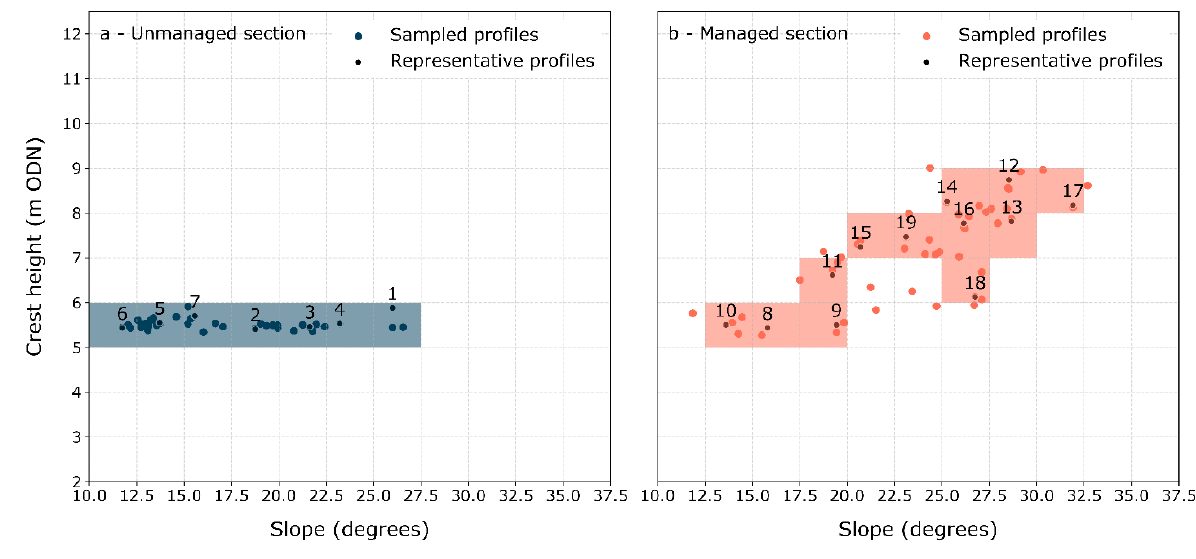
Figure 2. Scatter plots of crest height and seaward beach slope: ( a ) unmanaged profiles along the BPBS; ( b ) managed profiles along the BPBS. Shaded areas indicate the crest height and beach slope combinations chosen to ensure representation along the BPBS frontage.